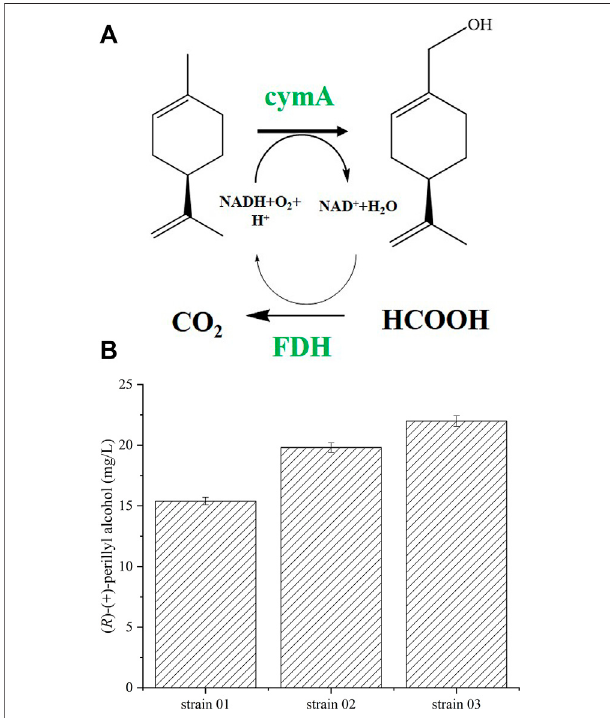
FIGURE1| ( R )-(+)-perillylalcoholsynthesisusingwholecellbiocatalysts. (A) ( R )-(+)-perillylalcoholbiosynthesisfrom( R )-(+)-limonene,usingawholecell system. (B) ( R )-(+)-perillylalcohol production withdifferentplasmids. Reaction conditions (20 ml): whole cell catalysts (OD 600 = 30), 25 μ l ( R )-(+)- limonene, 8.0 ml dioctyl phthalate (DINP), and PBS buffer (50 mM, pH 7.4) at 30 ° C for 6 h. Data expressed as mean ± s.d. ( n = 3). Abbreviations: CymAa, p-cymene monoxygenase hydroxylase, CymAb, p-cymene monoxygenase reductase, CymA, CymAa and CymAb, FDH, formate